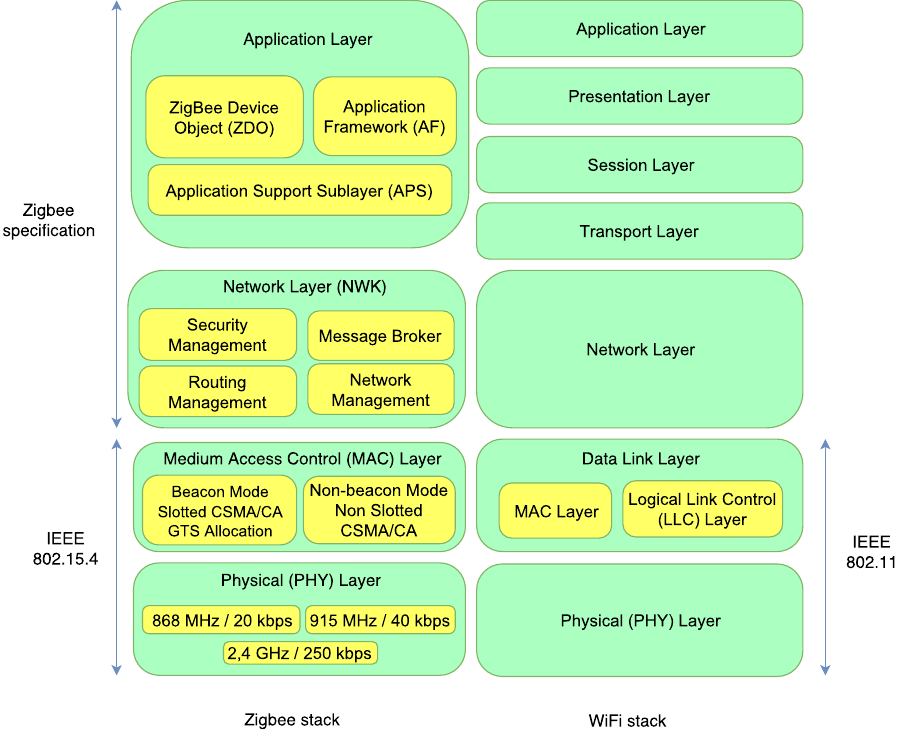
Figure 1. Zigbee versus WiFi protocol